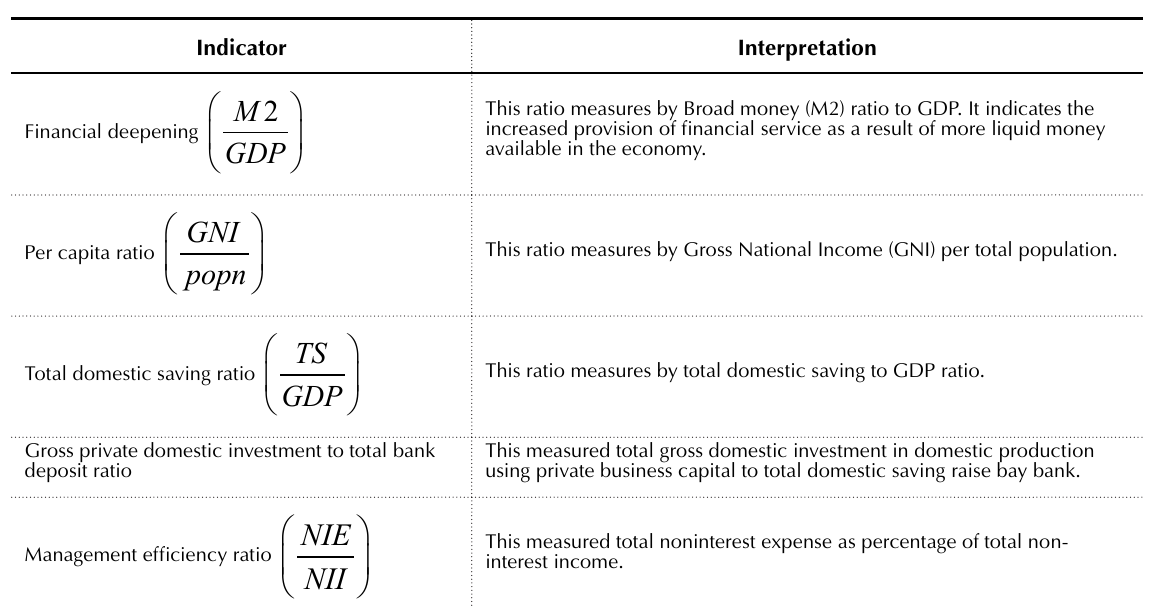
Table 7. Measures of investor loan funding